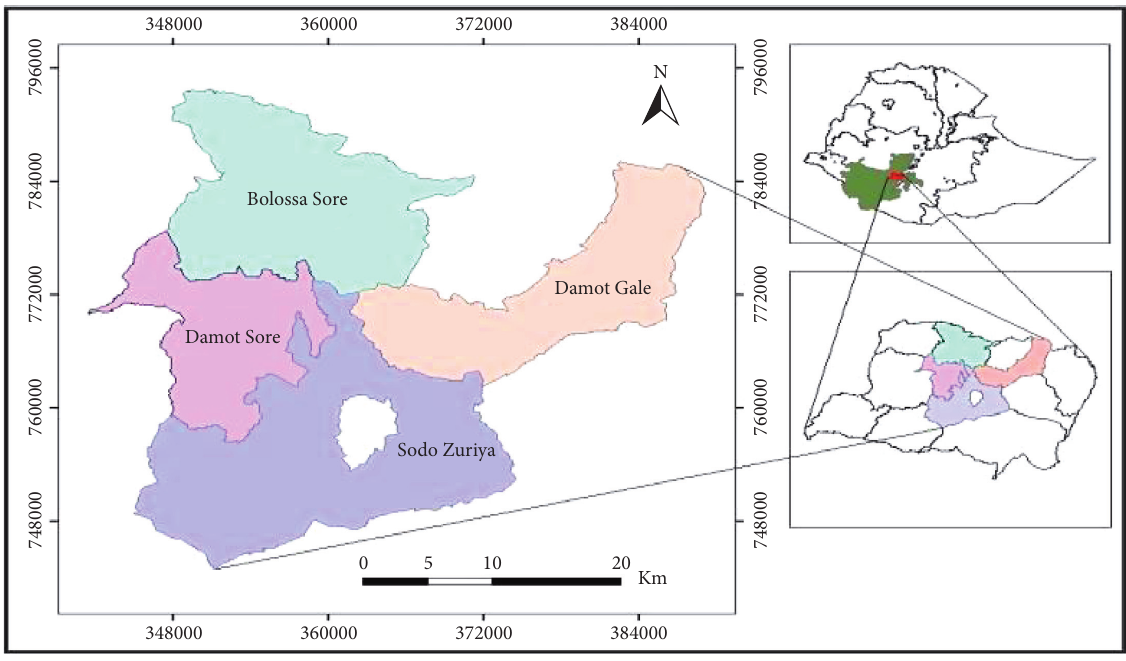
Figure 1: Locations map of the Wolaita Zone in Ethiopia.